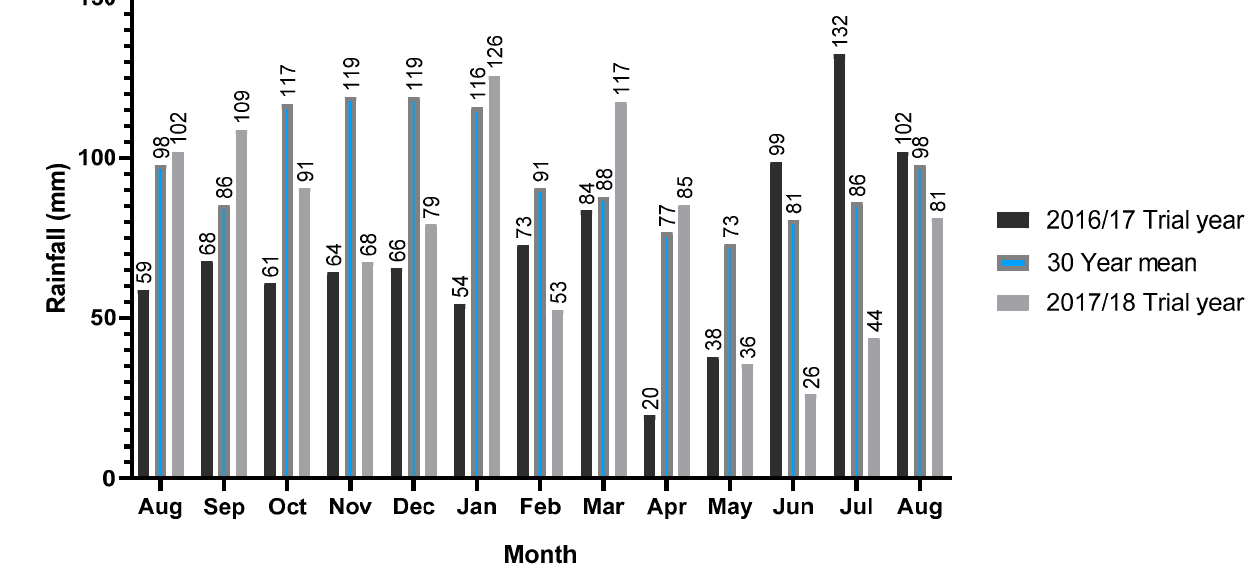
Figure A1. Monthly rainfall during the trial (mm).